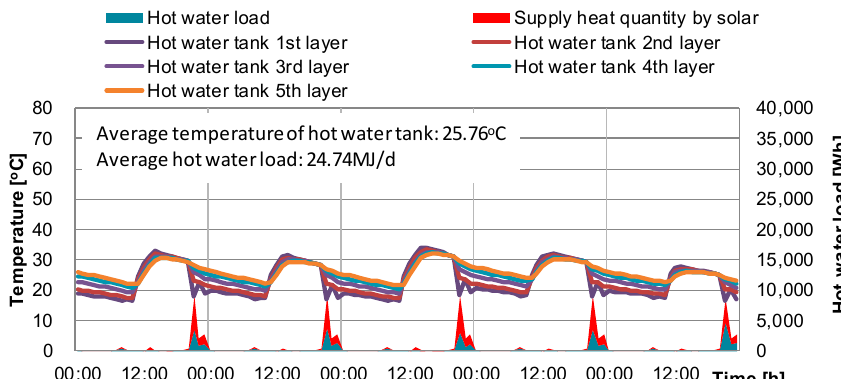
Figure 12. Temperature inside the hot water storage tank of the air-based solar system.